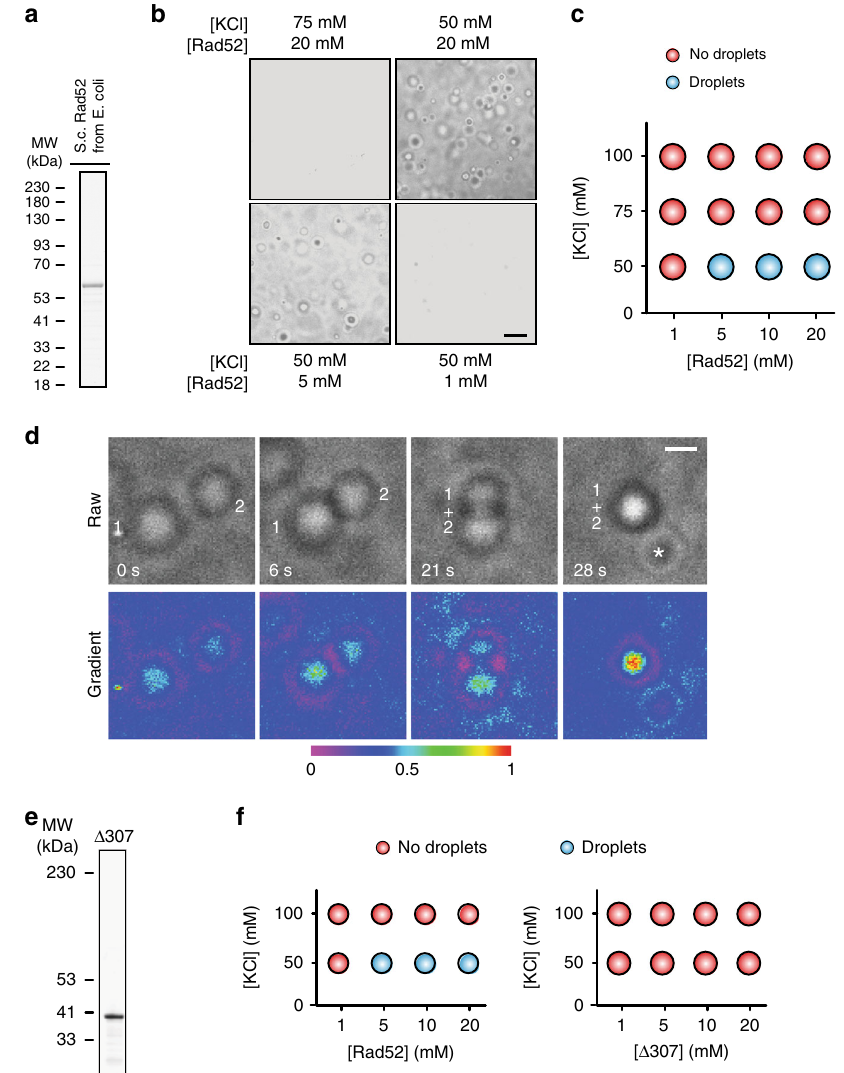
Fig. 2 Functional Rad52 forms liquid droplets in vitro. a – c Rad52 forms liquid droplets in vitro in a salt/protein concentration-dependent manner. Data represent results from experiments using three independent protein preparations. d Rad52 droplets fuse in vitro. Asterisk, separate droplet entering the imaging frame. Pseudo-colour scale, relative scale of material abundance. e , f Puri fi ed Rad52 C-terminal truncation Δ 307 fails to form droplets in vitro. Scale bars, 10 µ m ( b ) and 5 µ m ( d ). Source data are provided as a Source Data fi